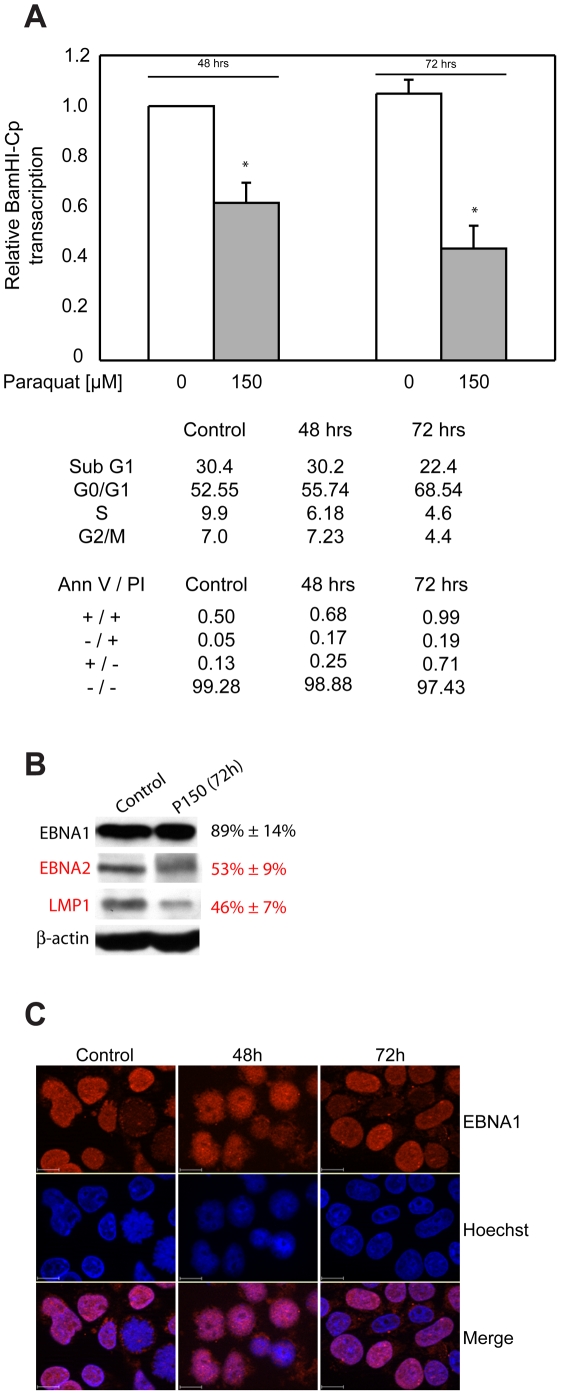
Mild oxidative stress reduces transcription from the EBV BamHI-Cp in a lymphoblastoid cell-line.(A) Paraquat treatment reduces the level of BamHI-Cp transcripts in treated NOLA-1 cells. Total RNA was extracted from control or cells exposed to 150 µM of paraquat for 48 or 72, reverse-transcribed with random hexamers. cDNA was used for real time PCR performed as described in the Methods section to evaluate changes in Cp transcripts relative to the endogenous control GAPDH transcripts. The results are presented relative to the BamHI-Cp transcript level observed in control cells, which was assigned a value of 1. Significant decreases in the level of BamHI-Cp transcripts were observed in cells with paraquat for 48 and 72 hours, such that transcript level was reduced to approximately 60% after 48 hours of treatment, and approximately 40% after 72 hours of treatment. Cell-cycle analyses conducted with several treated samples indicates that paraquat treatment does not increase the sub-G1 population. However, treated cells were consistently observed to accumulate in G0/G1. Treatment caused a small increase in the number of necrotic cells doubly-positive for annexin V and PI staining. Small increases were also seen for cells positive for only annexin V or only PI. (B) Paraquat treatment decreases expression of EBNA2 and LMP1, as evaluated by immunoblot. 2×105 control or cells treated with 150 µM paraquat (P150) for 72 hours were examined as described in Methods for expression of EBNA1, EBNA2 and LMP1. Band intensity was compared to that observed in control cells, and is expressed as percent of control along with standard deviation from two experiments. Expression was normalized to the level of β-actin protein detected in each sample. (C) Paraquat treatment does not alter the expression or localization of EBNA1. Control or treated cells were transferred to slides by cytospin, prior to fixation and permeabilization. EBNA1 expression was evaluated using rabbit polyclonal Ab 2638 as described in the methods, and detected using a TexasRed conjugated secondary anti-rabbit Ab. Cells were counterstained with Hoechst 33342. The absence of paraquat exposure, or length of treatment with 150 µm paraquat is indicated above each panel. Detection of EBNA1-specific signal, Hoechst signal and the merge is also indicated. The scale bar represents a distance of 10 µM.